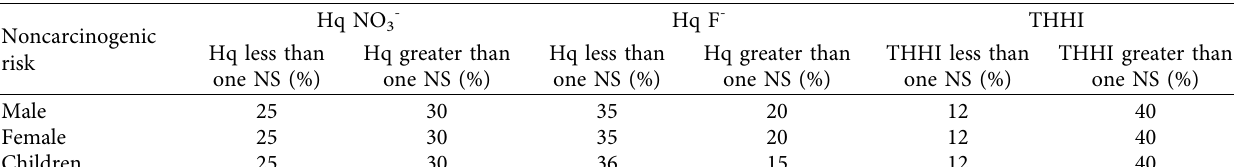
Figure 3: The total health hazard index is shown by a box and whisker plot (THHI). Table 2: Risk assessment for noncancerous substances.